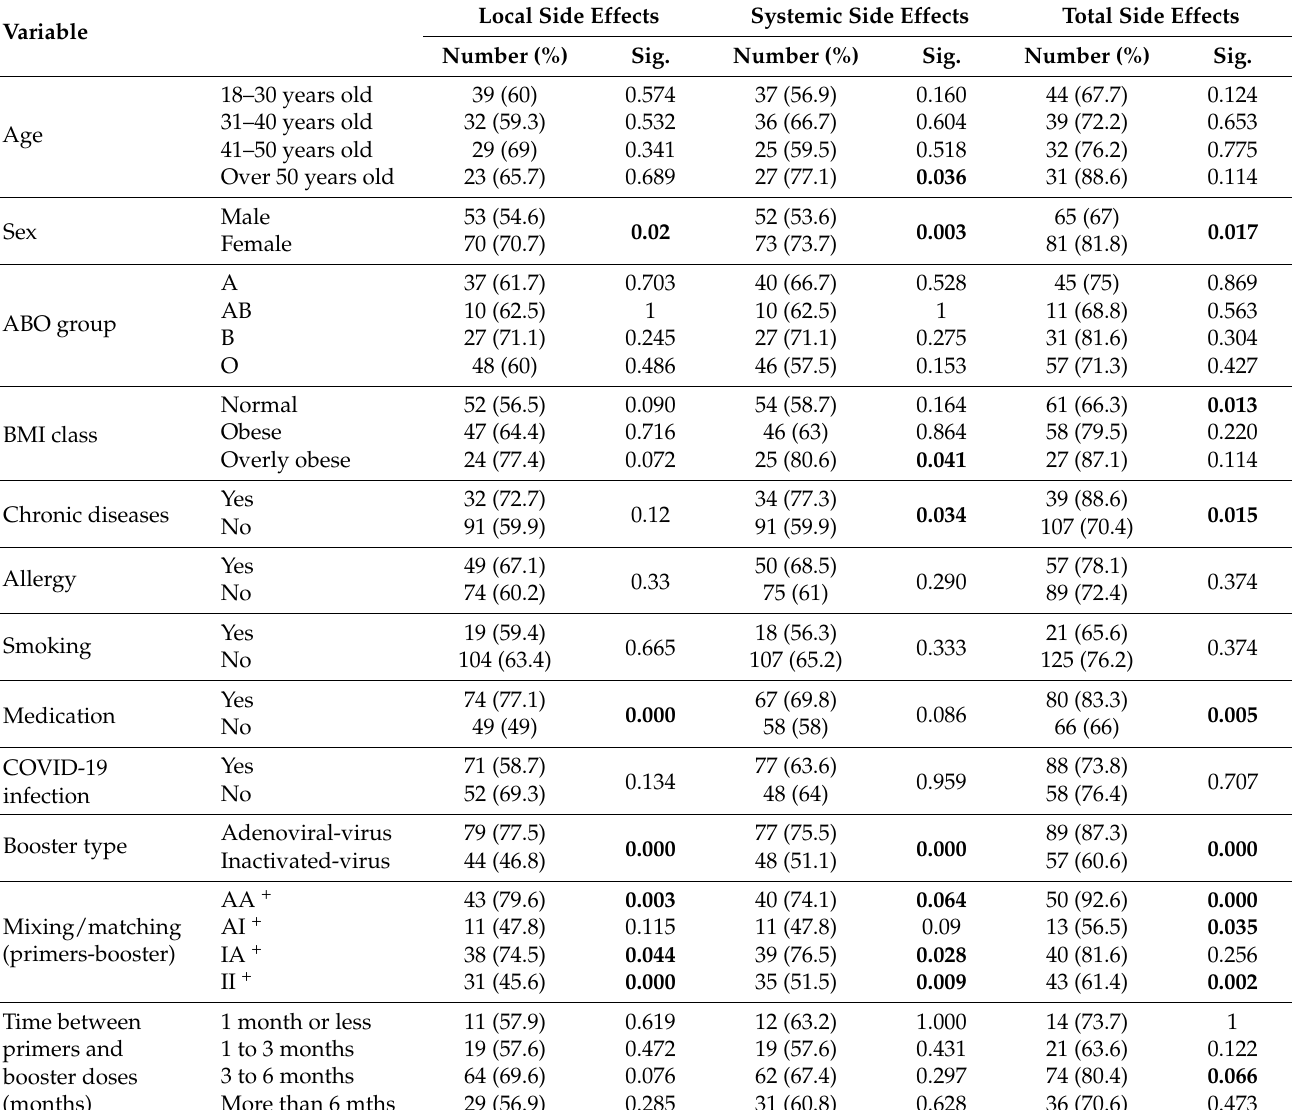
Table 5. Risk factors associated with side effects in the Algerian